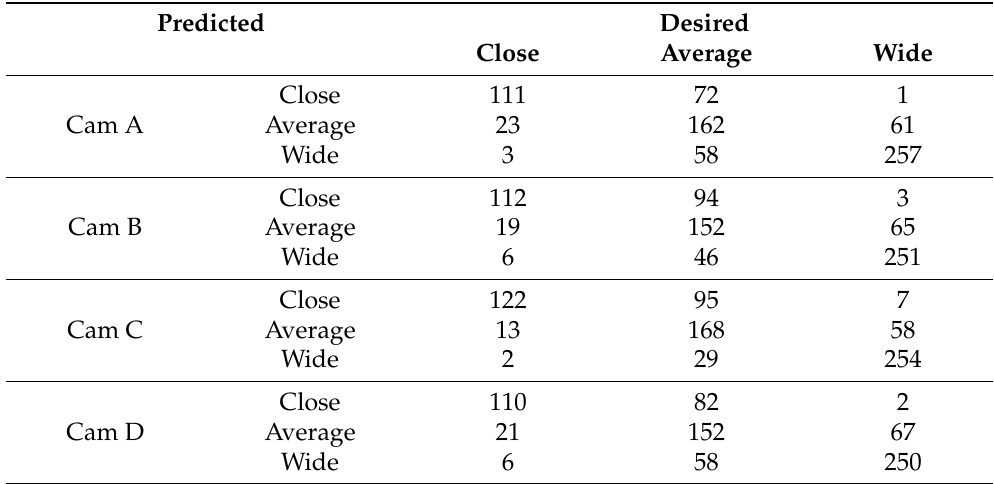
Table A1. Confusion matrices depict eye setting attributes prediction in each webcam versus the ground